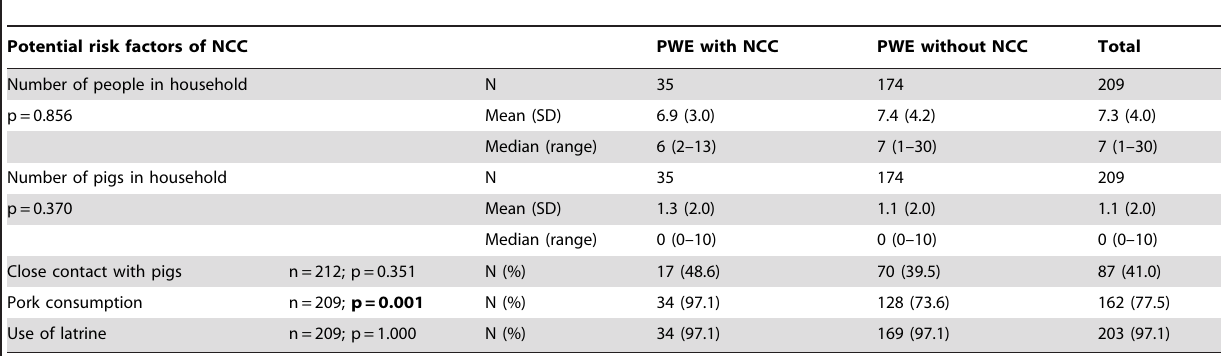
Potential risk factors of